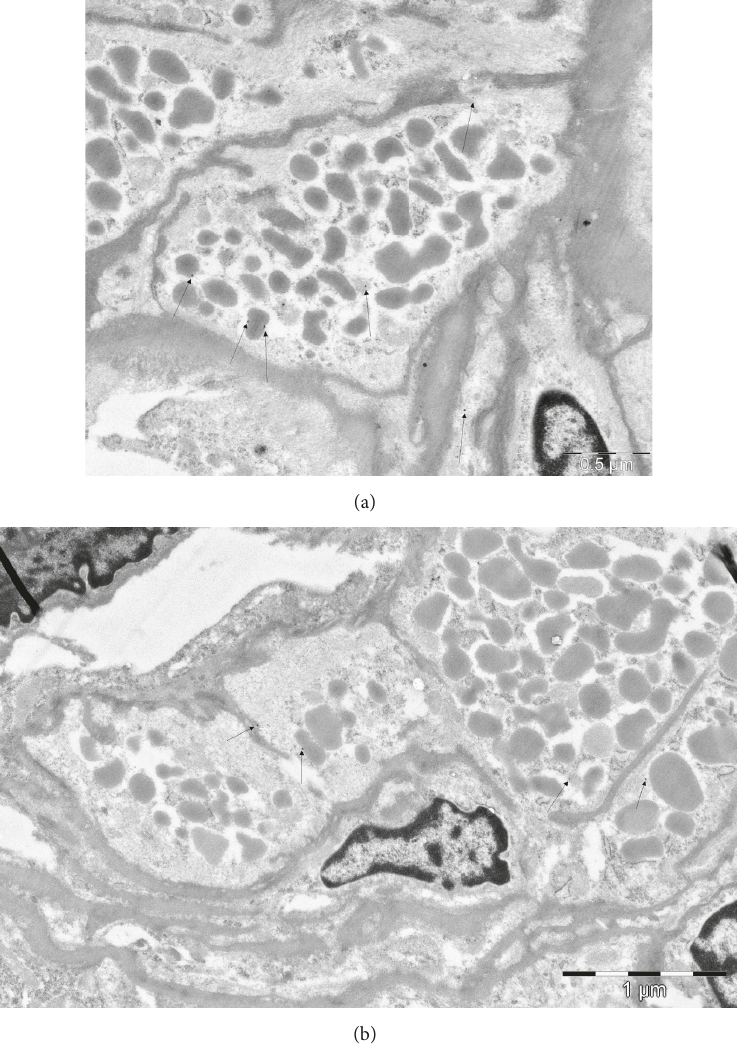
Figure 3: (a-b) Immunohistochemical signal was presented on surface and vacuoles of renin-positive SMCs and in cytoplasm of renin- positive SMCs. About 3000 TEM micrographs were analyzed for estimating the signal of renin receptors.